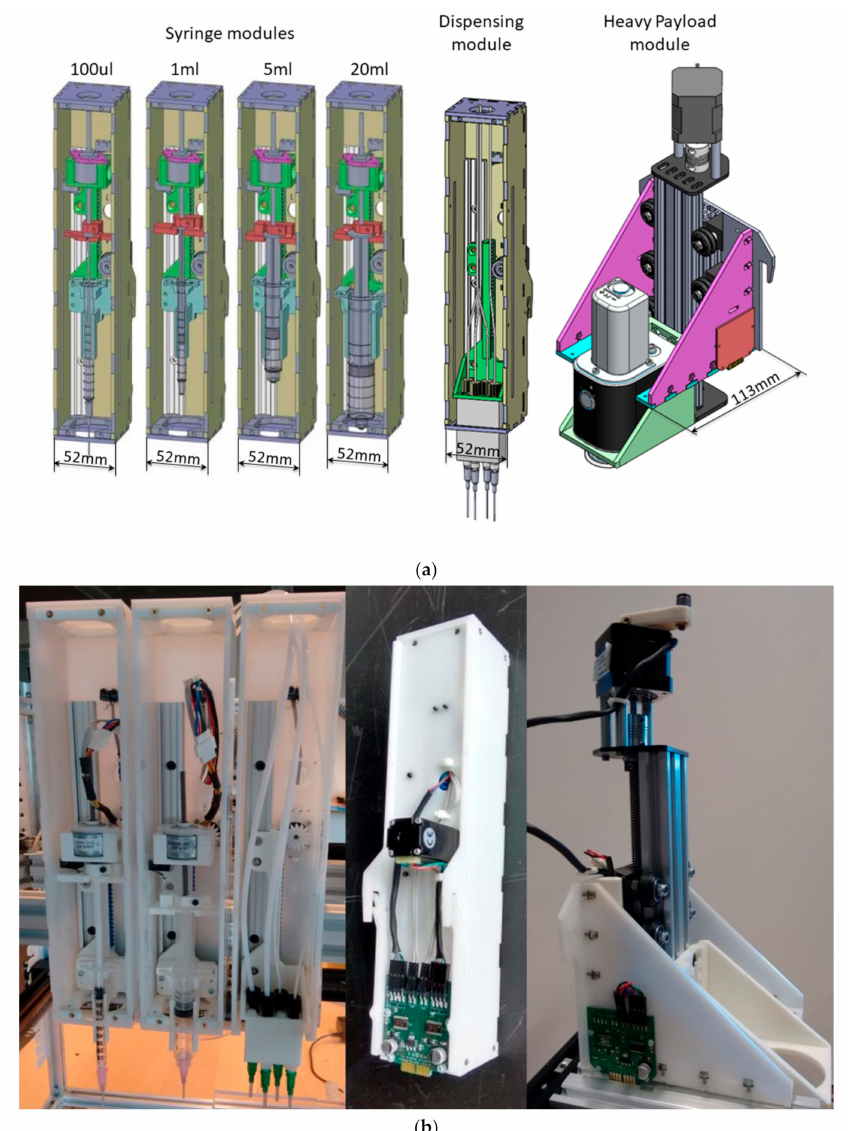
Figure 3. Modules in EvoBot. ( a ) Drawings of the di ff erent modules from left to right: syringe modules from 100 µ L to 20 mL, a dispensing module, and a heavy payload module with an OCT scanner; ( b ) The implemented modules from left to right: 1 mL syringe, a 5 mL syringe and a dispensing modules on the head of the robot; back of one syringe module; and a heavy payload